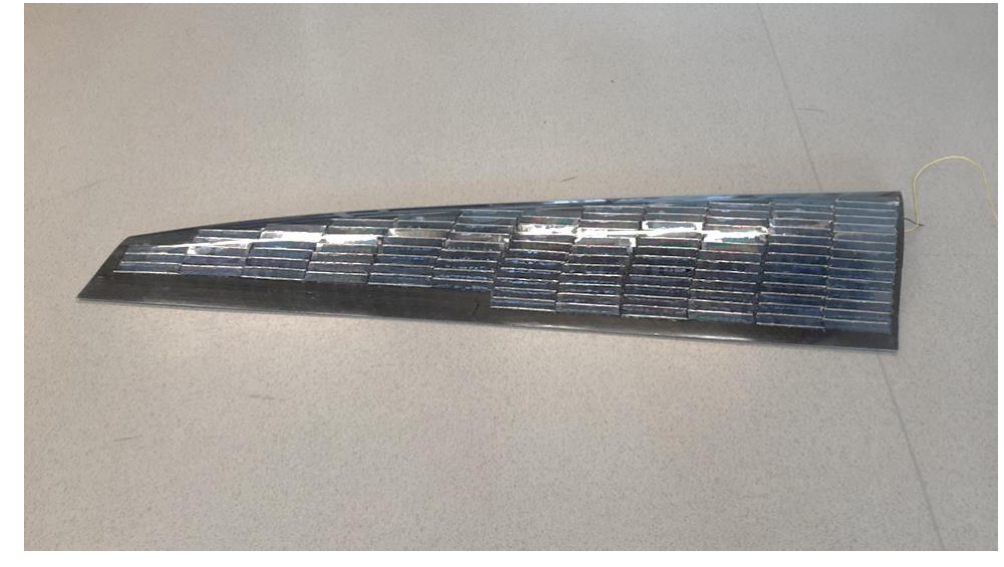
Figure 9. Ultra-light wings with embedded micro-texturized photovoltaic cells.